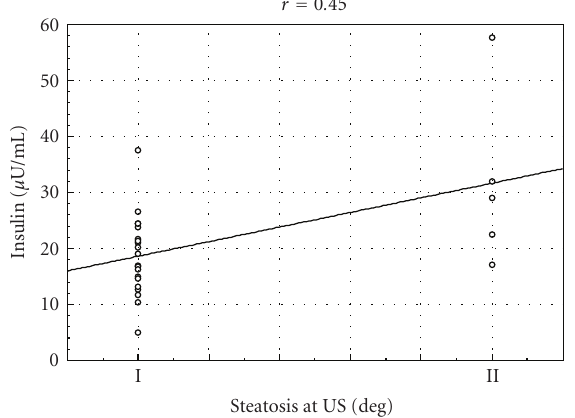
Figure 1: Correlation between degree of steatosis at US and Insulin levels at baseline conditions of adolescent obese boys.